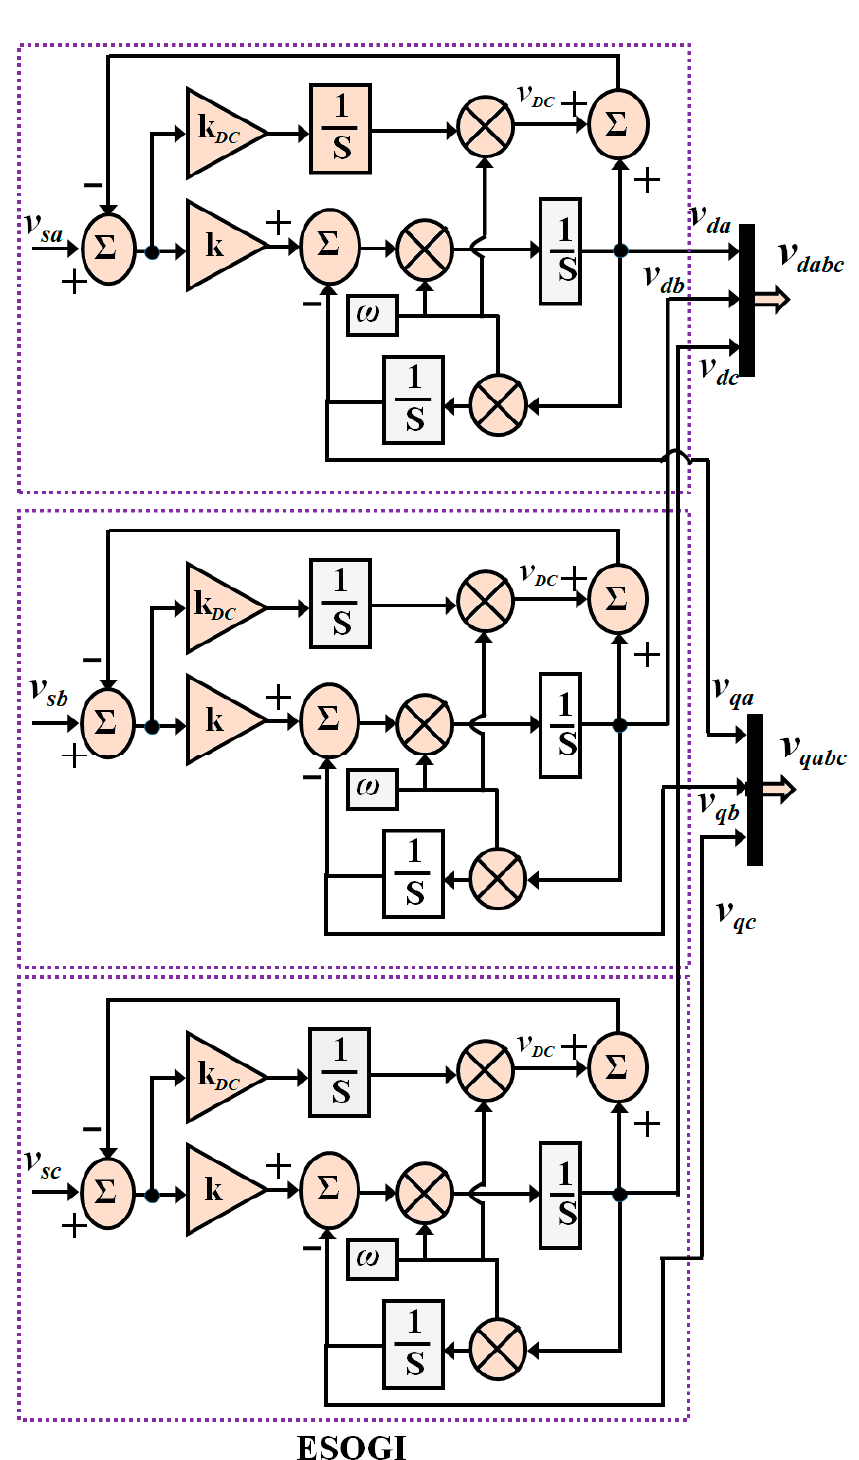
Figure 5. Schematic diagram of enhanced second order generalized integrator (SOGI)-based fundamental component extractor.